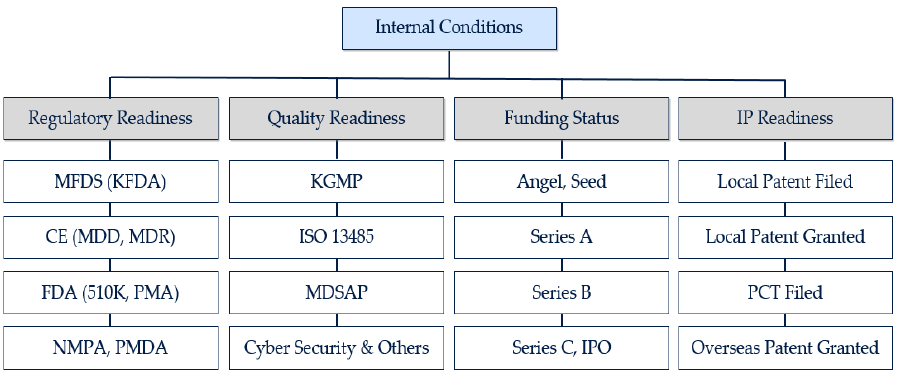
Figure 1. Research framework: internal readiness for partnership .